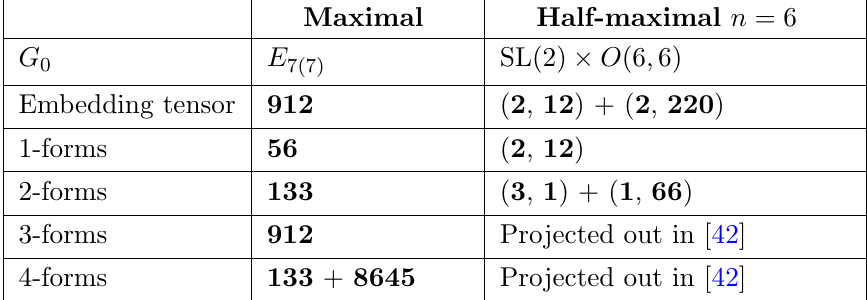
Table 4 . Duality groups and representations of the tensor hierarchy in maximal and half-maximal supergravities in four space-time